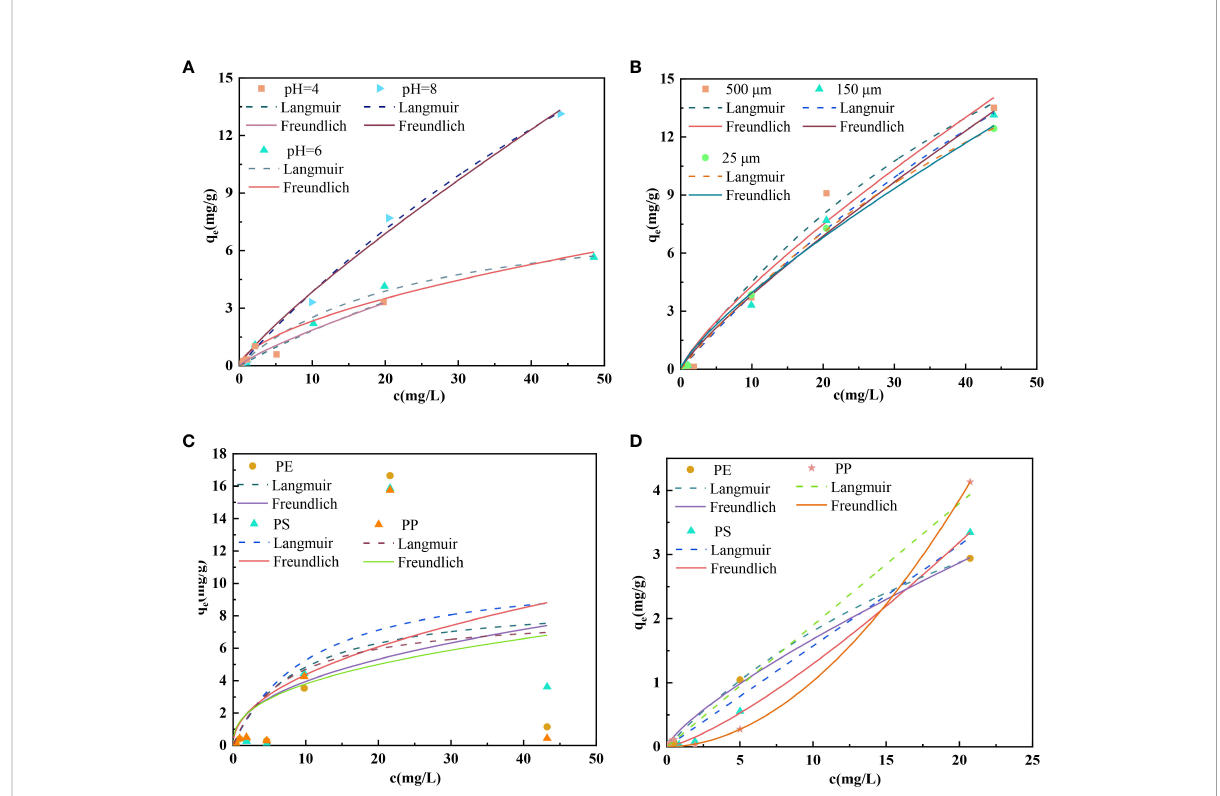
FIGURE 2 Adsorption isotherms of Tl(I) on microspheres. (A) PS with different pH; (B) PS with different particle sizes; (C) MPs in seawater (salinity of 32 ‰ ); (D) MPs in seawater (salinity of 15 ‰